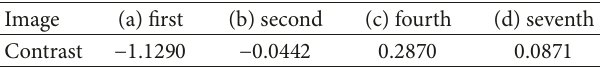
Table 3: Contrast of aluminum and silicon in the reconstructed images from Figure